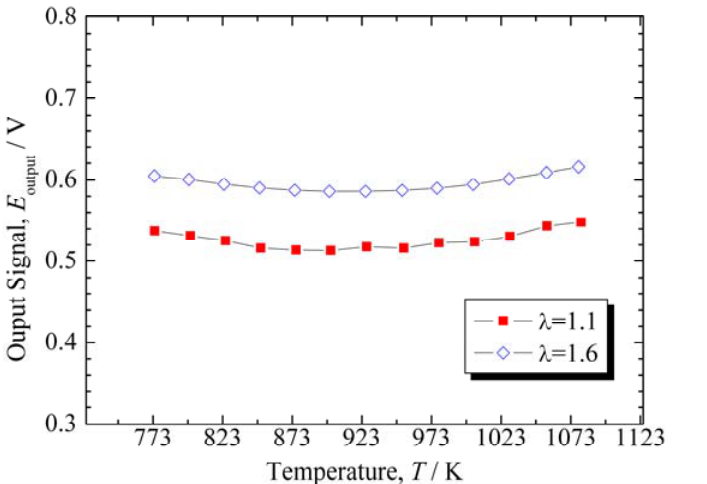
Figure 8. Output signal of the sensor element obtained using the electric circuit shown